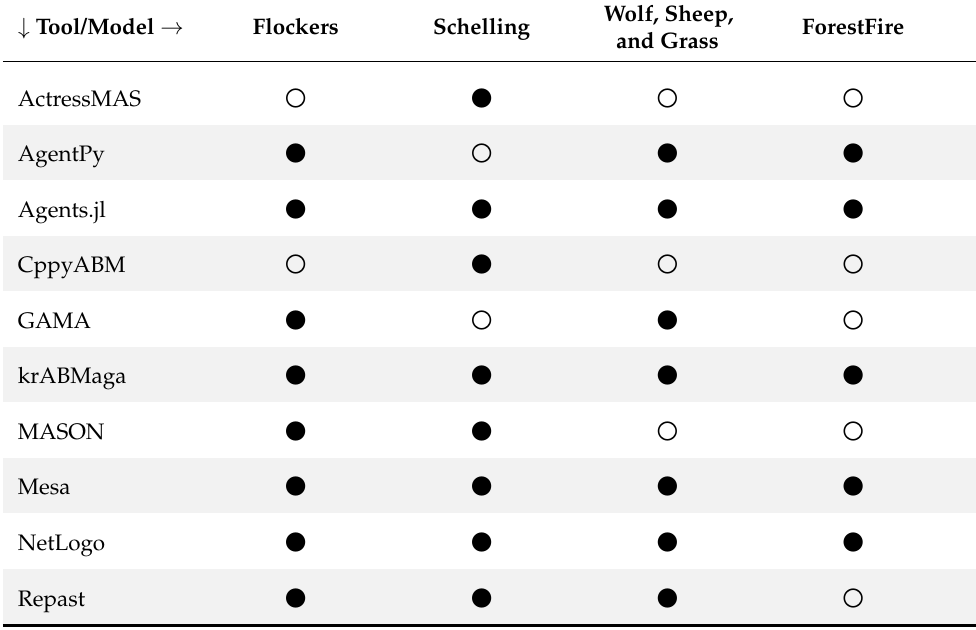
Table 7. Summary of whether each model was available for a given platform ( ○ ) or has been